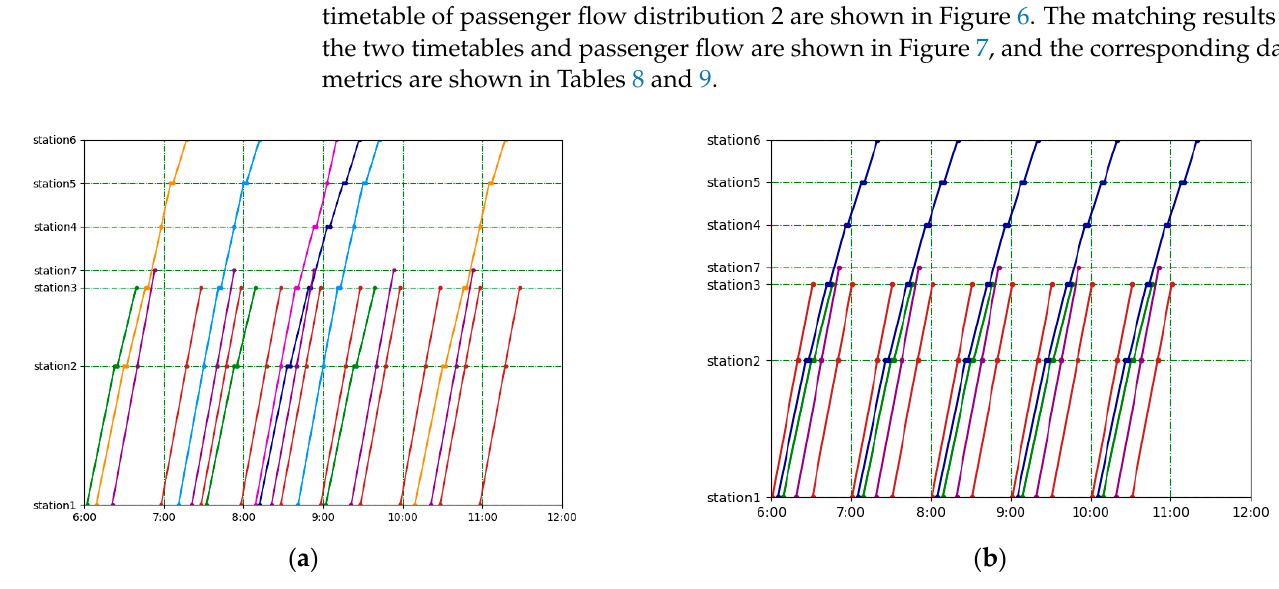
Figure 6. Multi-cycle train timetable and single-cycle train timetable under scenario 2. ( a ) Multi-cycle train timetable. ( b ) Single-cycle train timetable. Red, green, blue, orange, violet, navy blue and purple represents Line 1, 2, 3, 4, 5, 7 and 10 in Table 3, respectively.